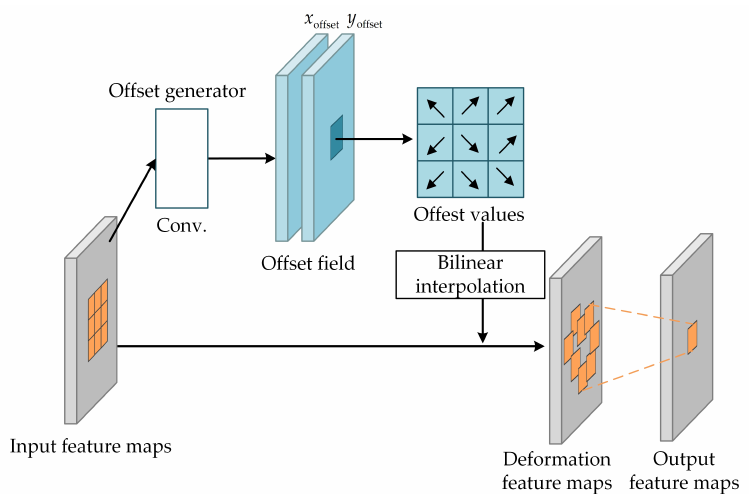
Figure 5. Illustration of 3 × 3 deformable